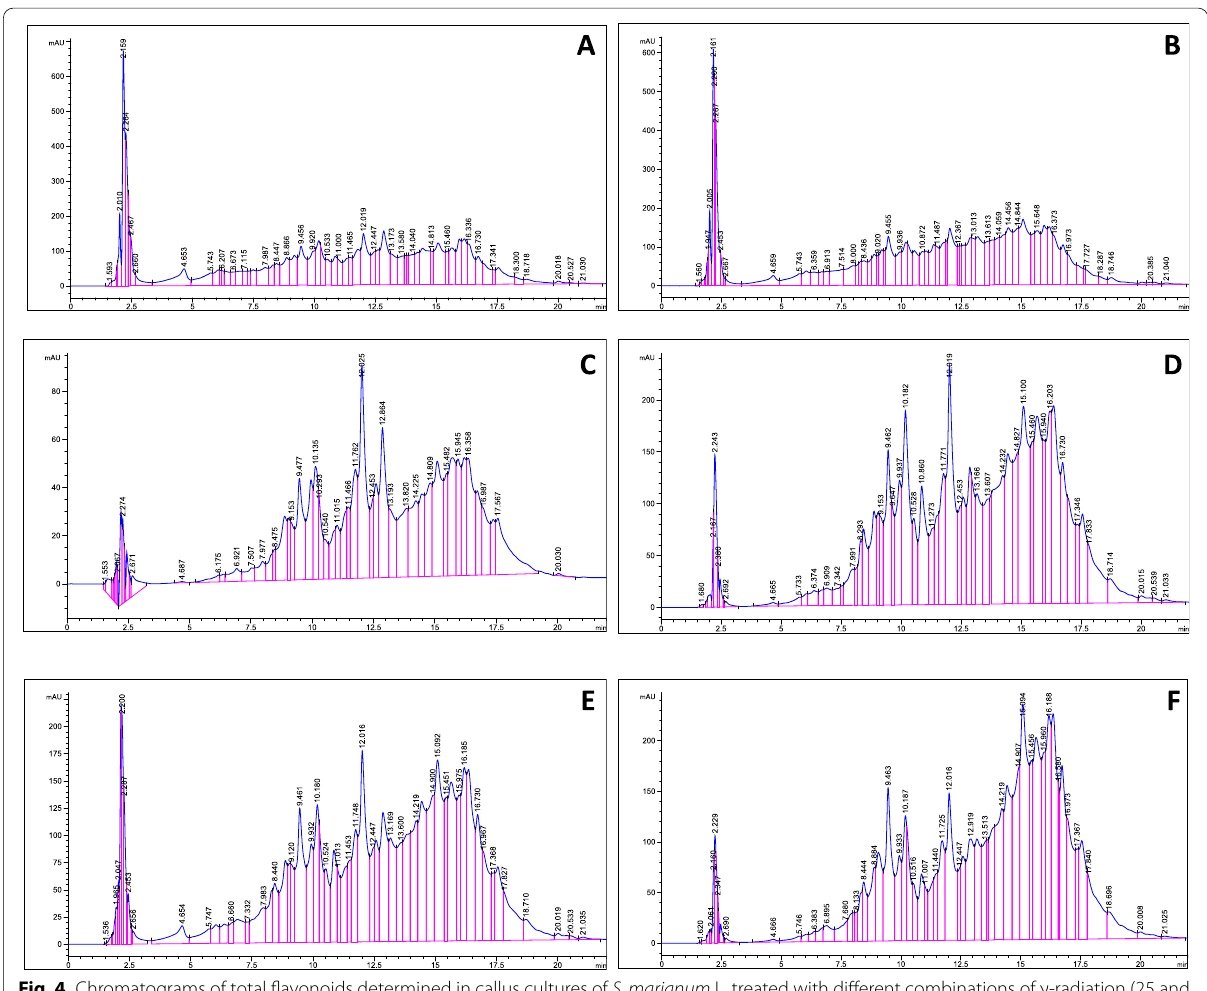
Fig. 4 Chromatograms of total flavonoids determined in callus cultures of S. marianum L. treated with different combinations of γ‑radiation (25 and 50 Gy) and the amino acid precursor Phe (1 mg/l). A : control, B : 1 mg/l Phe, C : 25 Gy γ, D : 25 Gy γ